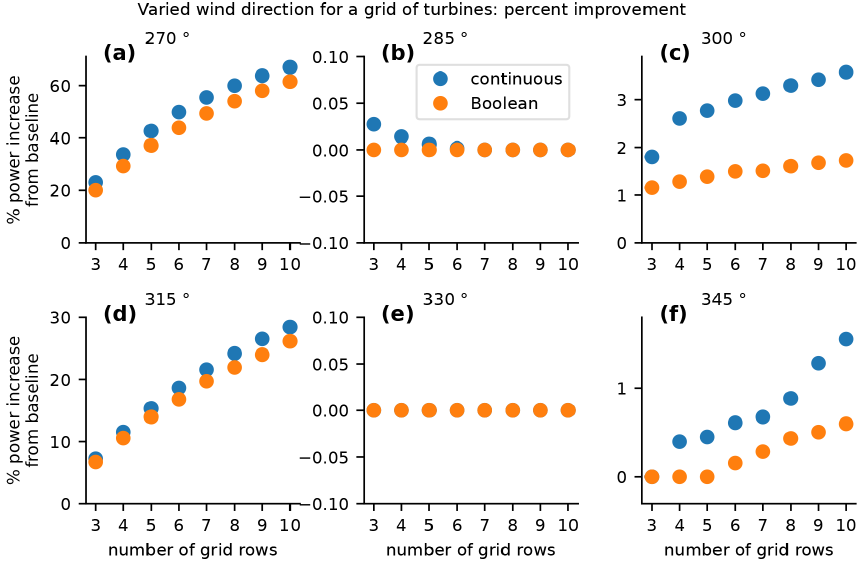
Figure 6. Comparison of the absolute percent increase in power over the nonyawed baseline wind plant optimized with a traditional contin- uous optimization compared to our novel Boolean optimization. These results are for a grid wind power plant for which, within each panel, the x axis indicates different numbers of rows in the plant. Each panel shows results for a different wind